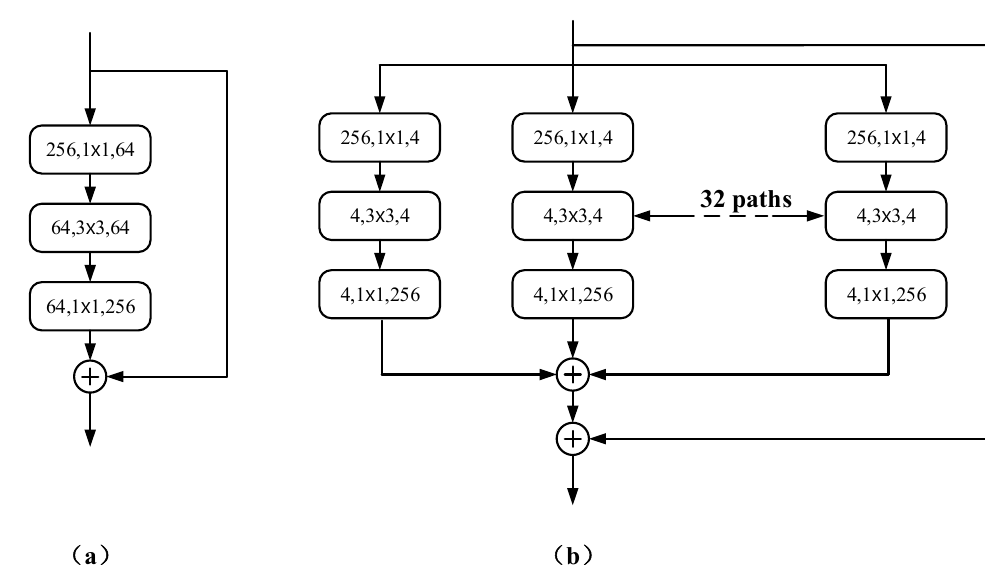
Figure 3. ( a ) An early version of Res-Net; ( b ) an aggregation block of ResNeXt50.